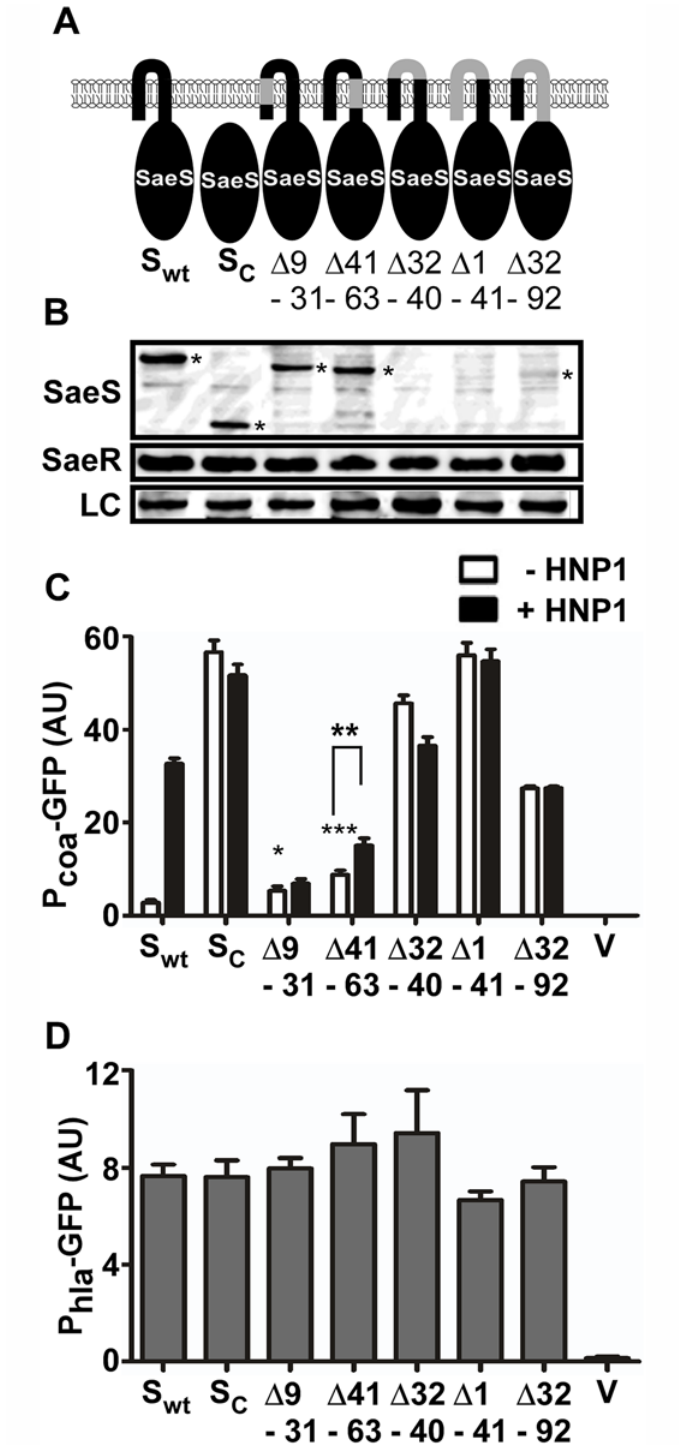
Fig 3. The extracytoplasmic linker peptide restrains the basal kinase activity. (A) A diagram for the deletion mutants of SaeS. The deleted amino acid sequences are indicated in gray. The numbers represent the amino acid positions. wt, wild type; S c , cytoplasmic domain of SaeS; Δ , deletion. (B) Expression of the deletion mutants of SaeS analyzed by Western blot. Cells at exponential growth phase were used. SaeS band is indicated by an asterisk. LC, loading control. (C) The effect of the deletion mutations on